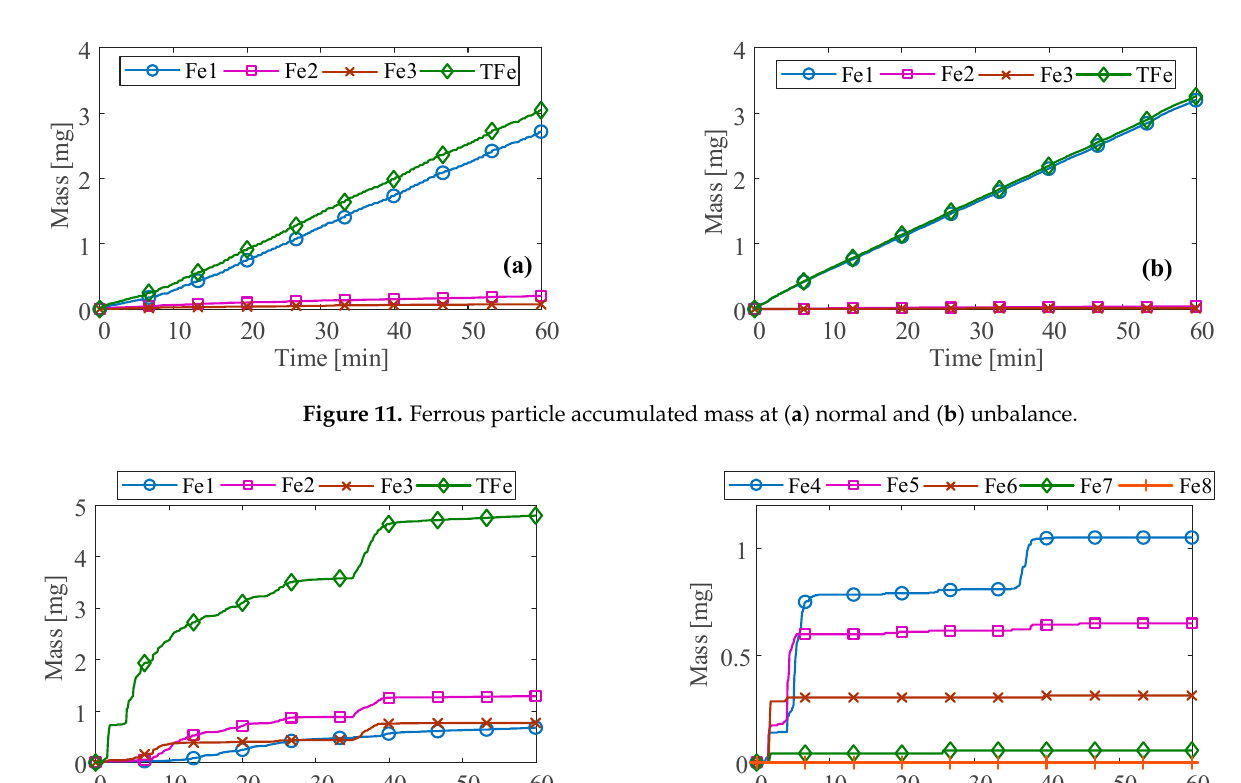
particles in the fi rst seven size ranges. After large-size nonferrous contaminants come into